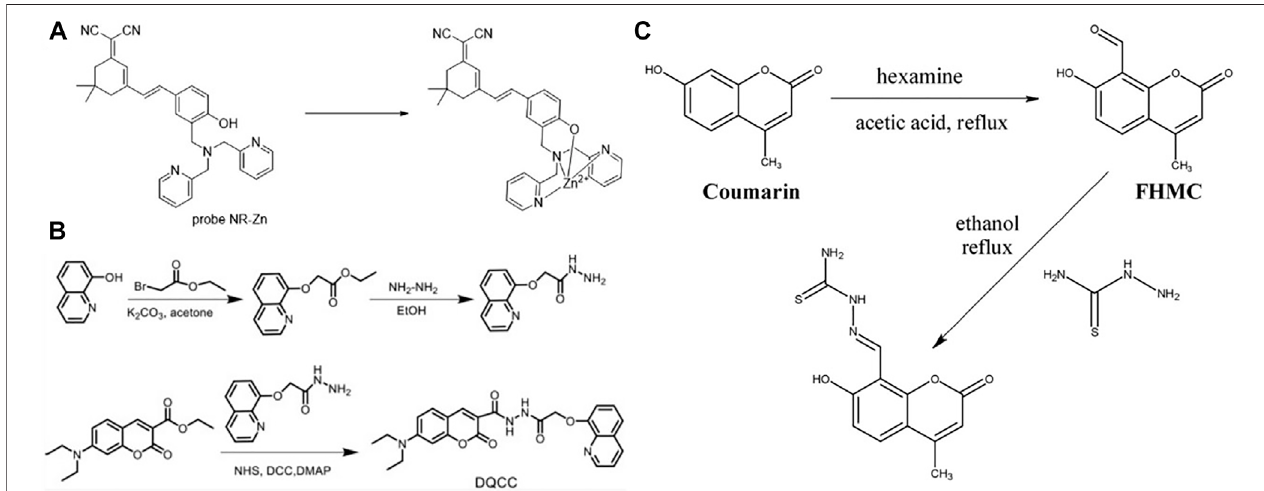
FIGURE6|(A) ThestructureoftheprobeNR-ZnanditsinteractionmodewithZn(II)ion(ZhangY.etal.,2020); (B) ThesynthesisrouteofDQCC(Kangetal.,2019); (C) The synthesis route of probe 1 (Wang et al., 2018).